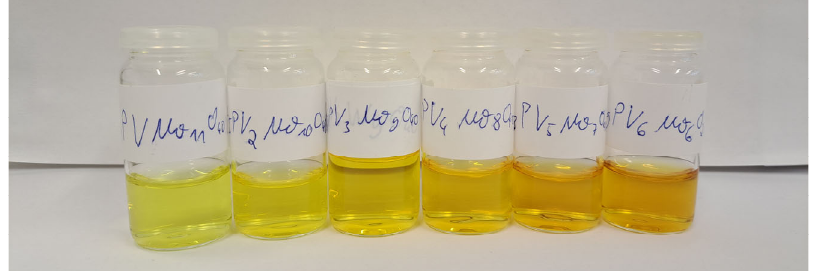
Figure 11. Solutions (1 g/L) of the different V(V)-substituted molybdates, with increasing degree of substitution from left to right, x = 1–6.